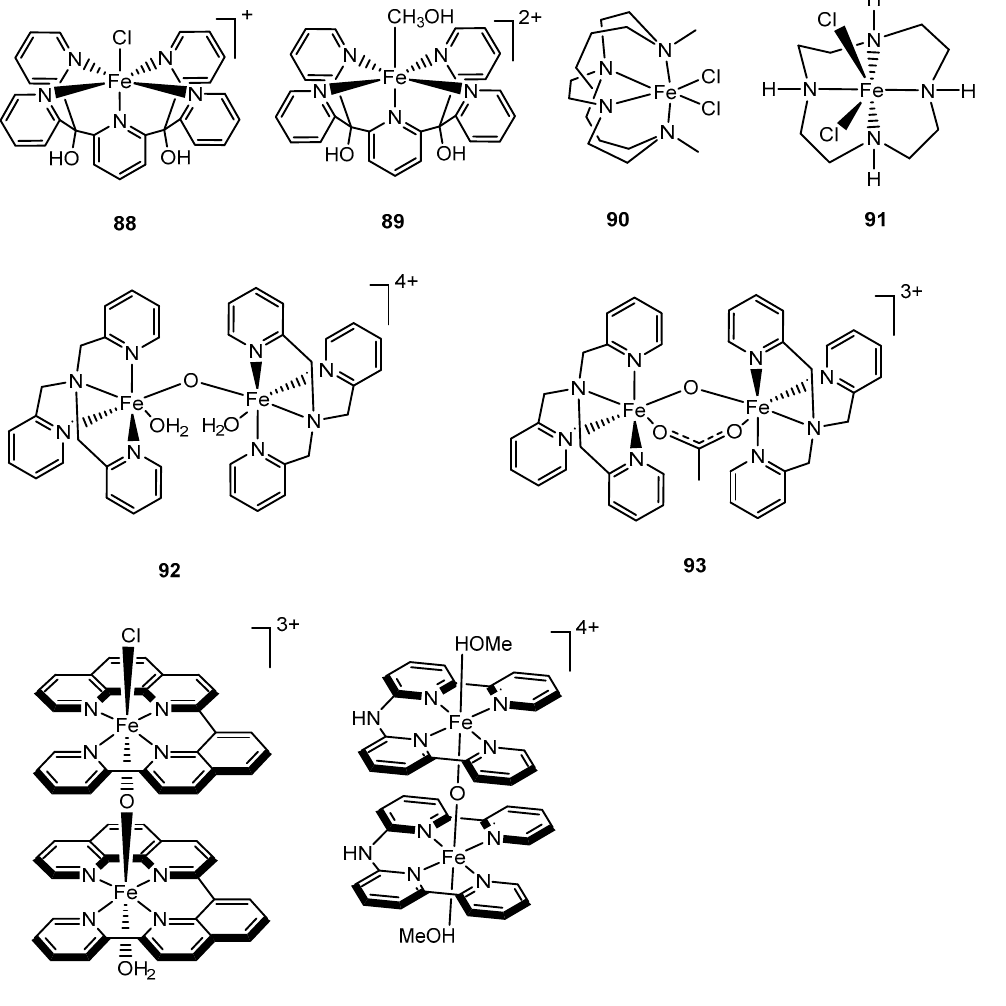
Figure 7. Selected iron complexes 72–95 for water oxidation: Fe-TAMLs ( 72a – 72e , TAML = tetraanionic tetraamido mac- rocyclic ligands) [145]; Biuret-modified Fe-TAMLs ( 73a – 73b , TAML = tetraanionic tetraamido macrocyclic ligands) [146];